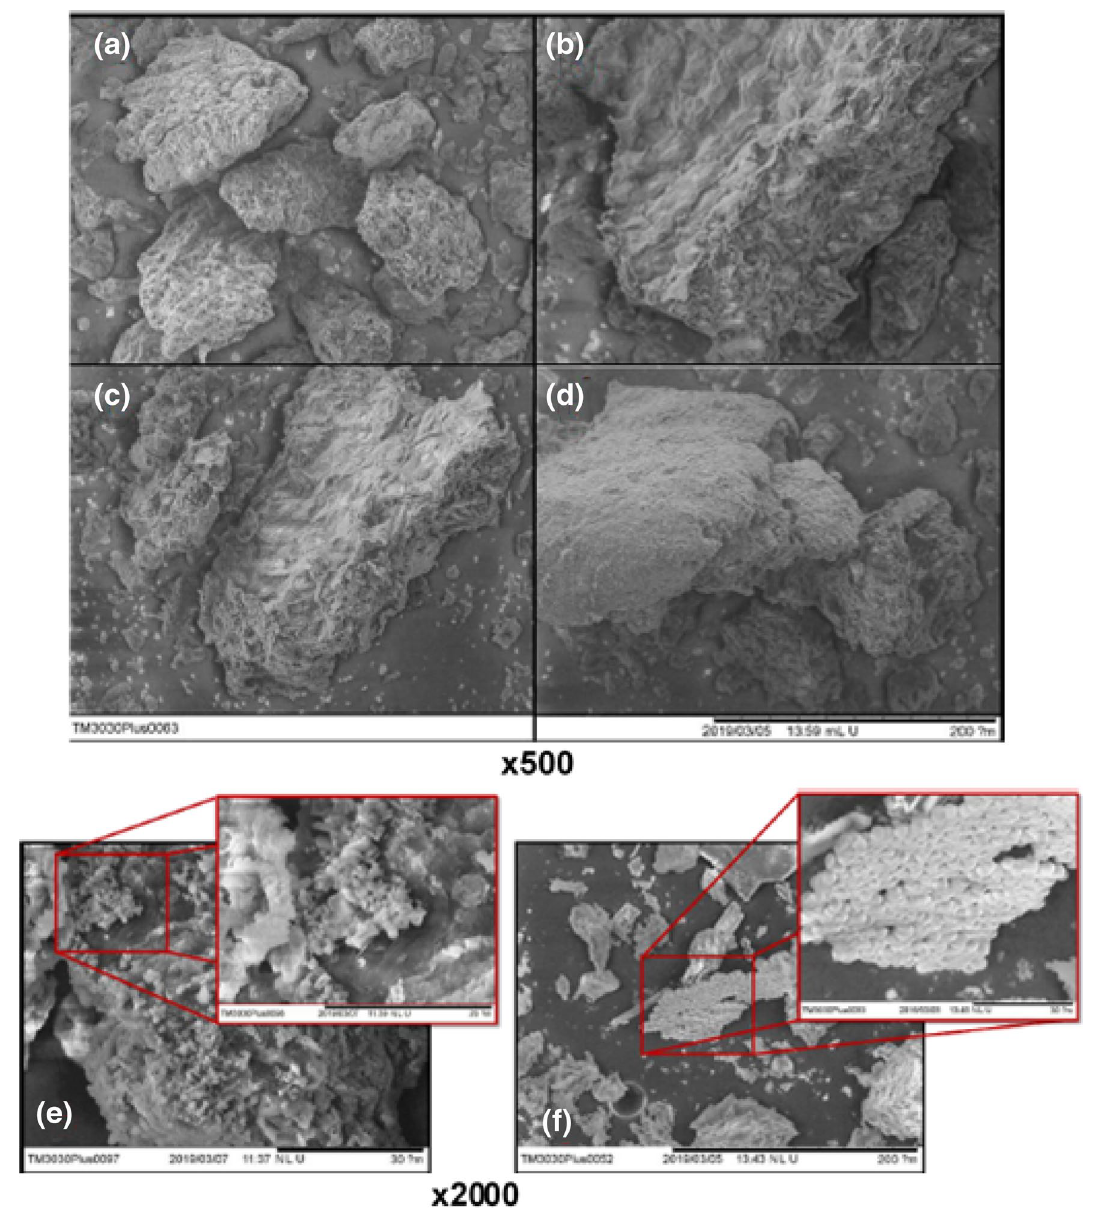
Fig. 1 SEM images at ×500 magnification of a raw F. serratus , b FS-HC200, c FS-HC220, and d FS-HC250. At ×2000 magnification are images of e deposits on raw F. serratus , and f small cluster of microspheres formed with